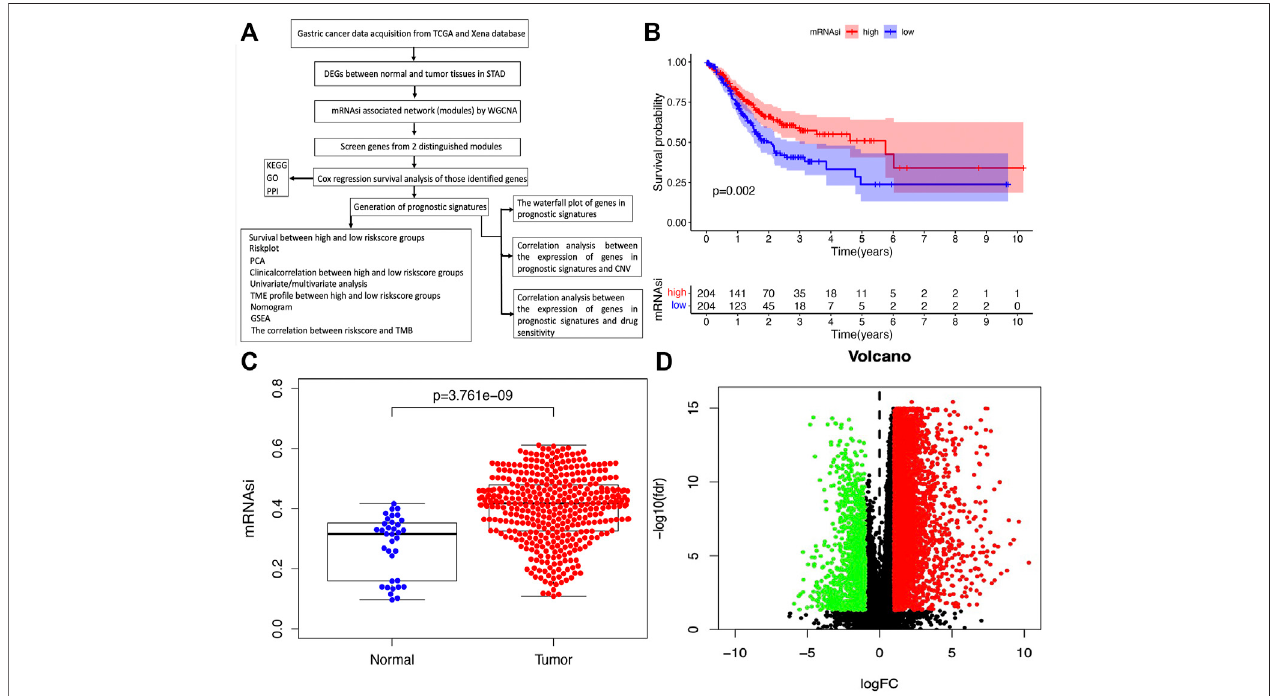
FIGURE 1 | Identi fi cation of DEGs between normal and tumor tissues in STAD. (A) The fl ow chart for identi fi cation of mRNAsi related signature in STAD. (B) Kaplan – Meier curves showthatthe lowmRNAsigrouphad greatermortalitythan thehigh mRNAsi group. (C) Differences inmRNAsibetweennormal and tumor tissues in STAD. (D) Identi fi cation of DEGs between normal and tumor tissues in STAD; green and red indicate downregulated and upregulated genes, respectively.